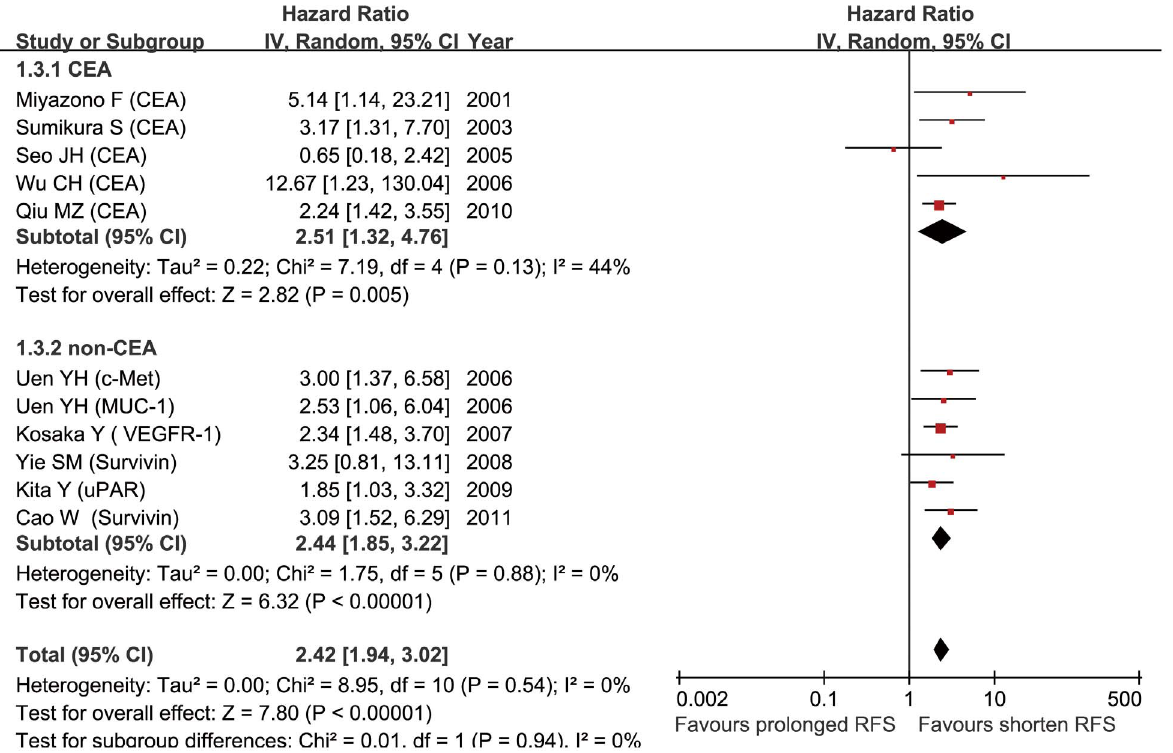
Figure 2. Summary estimates of hazard ratio (HR) for RFS. RFS, relapse-free survival.